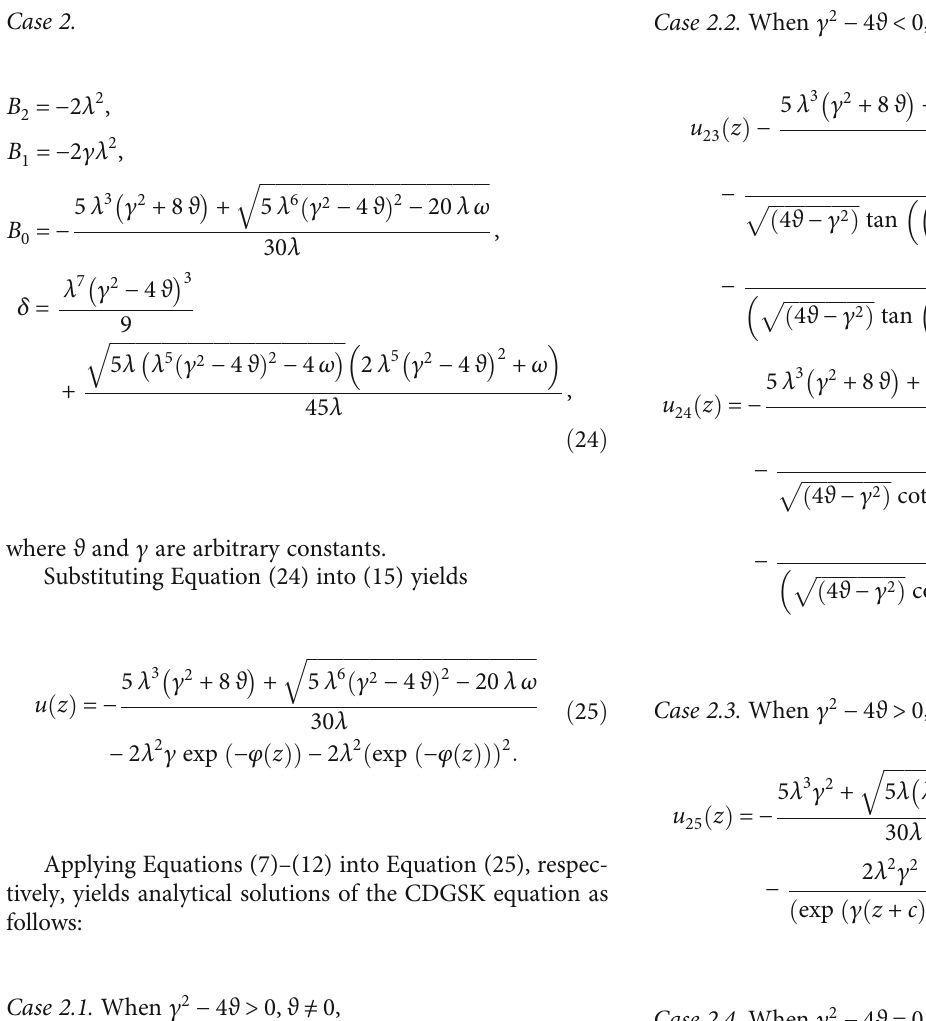
p ffiffiffiffiffiffiffiffiffiffiffiffiffiffi γ 2 − 4 ϑ